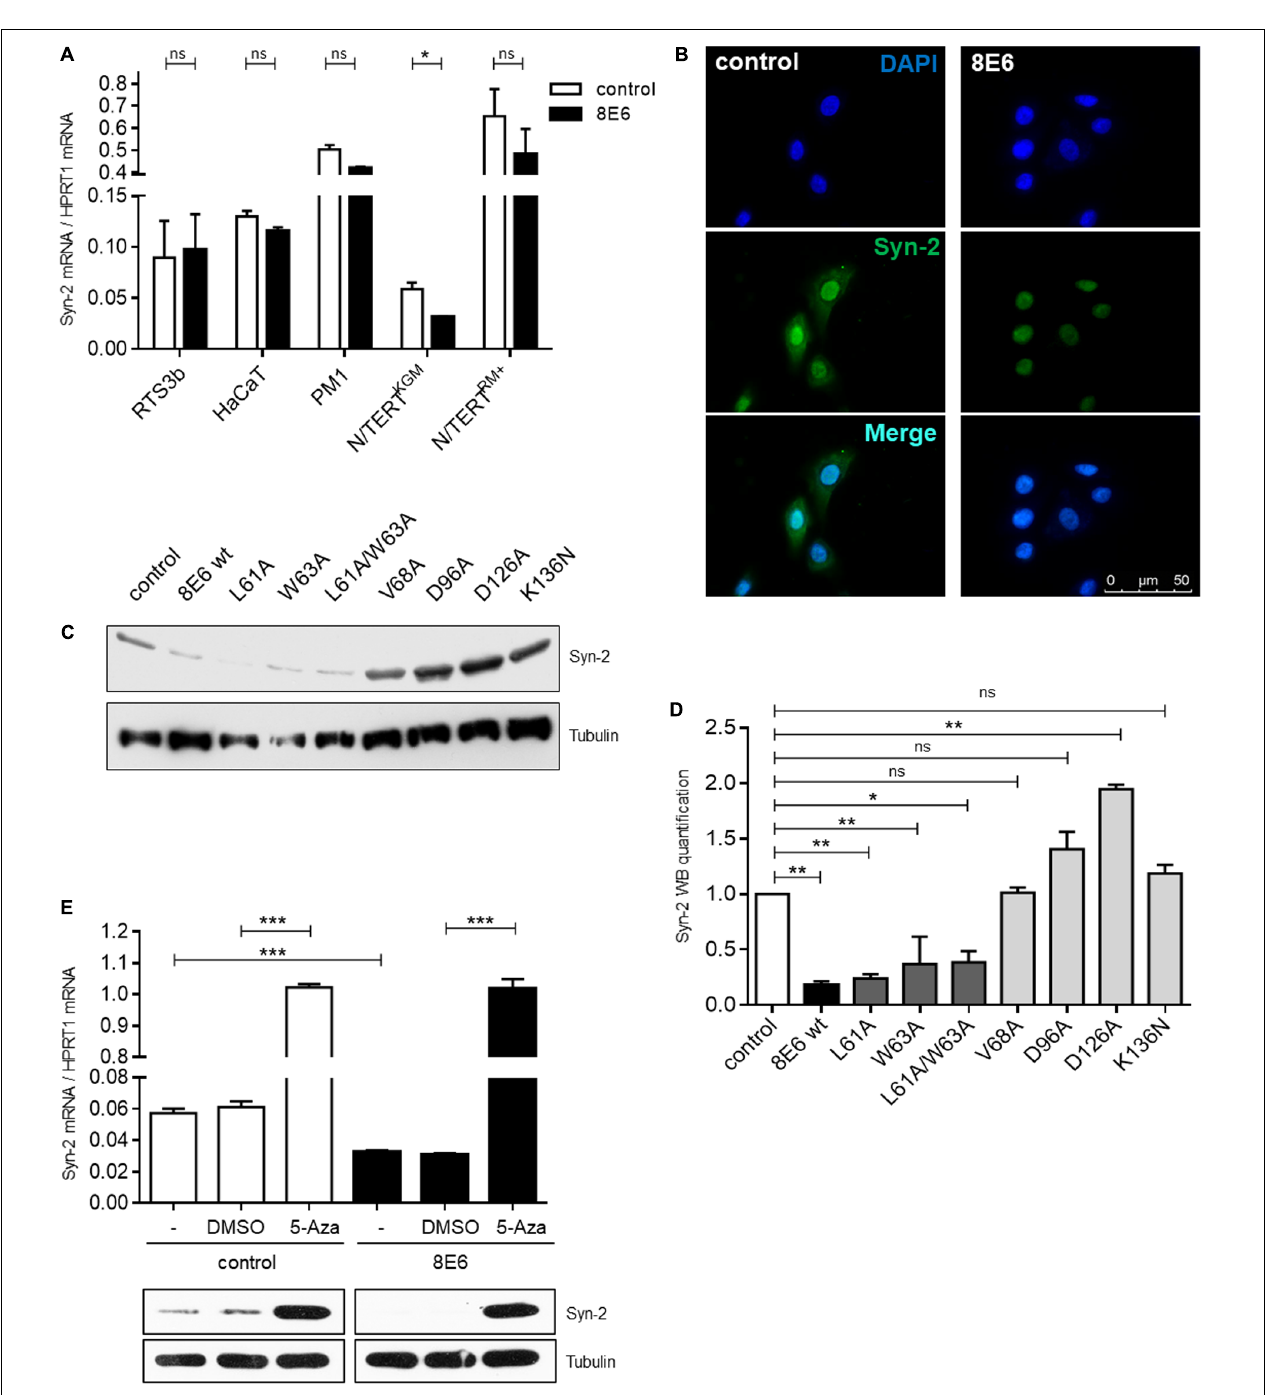
FIGURE 3 | Syntenin-2 expression is repressed by HPV8-E6 in keratinocytes with basal cell characteristics through promoter hypermethylation. (A) Quantification of Syntenin-2 mRNA expression by qRT-PCR in empty vector and HPV8-E6 expressing RTS3b, HaCaT, PM1 and isogenic N/TERT keratinocytes cultured either in RM+ or KGM. (B) Representative immunocytochemical staining of Syntenin-2 in N/TERT KGM -control (Left) and N/TERT KGM -8E6 (Right) demonstrating reduction of mainly cytoplasmic Syntenin-2 in HPV8-E6 positive cells (blue: DAPI; green: Syntenin-2). (C) Representative Western blot showing Syntenin-2 in total cell extracts of N/TERT KGM expressing either HPV8-E6 wild type or the E6 mutants L61A, W63A, L61A/W63A, V68A, D96A, D126A or K136N. Loading was confirmed by immunoblotting for Tubulin. (D) Quantification of Syntenin-2 protein levels from (C) normalized to Tubulin protein levels. (E) Quantification of Syntenin-2 mRNA expression in N/TERT KGM -control and N/TERT KGM -8E6 cells after treatment with 10 µ M 5-Aza or DMSO ( n = 3 independent experiments, measured in duplicate, Upper). Data are presented as mean ± SEM ( ∗∗∗ p < 0.001). Western blot analysis of Syntenin-2 in extracts from cells treated with 5-Aza. Equal loading was confirmed by immunoblotting for Tubulin